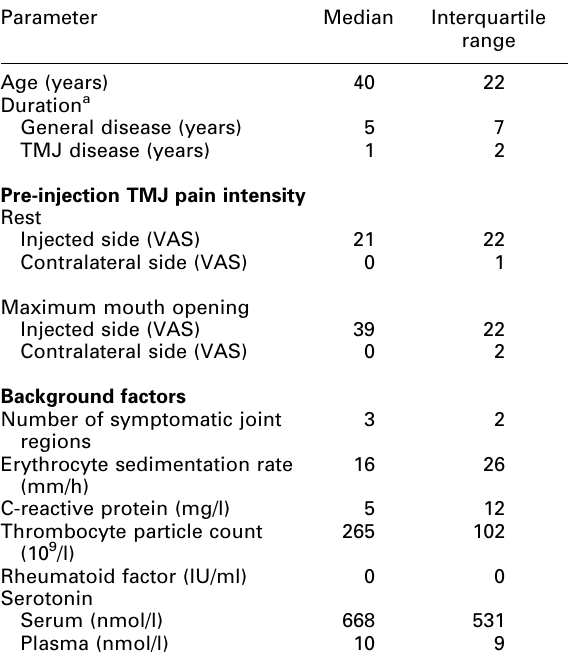
Table 1. Demographic and background factors in 11 patients with chronic polyarthritides receiving injections of 3 mg/3 ml of granisetron into the temporomandibular joint